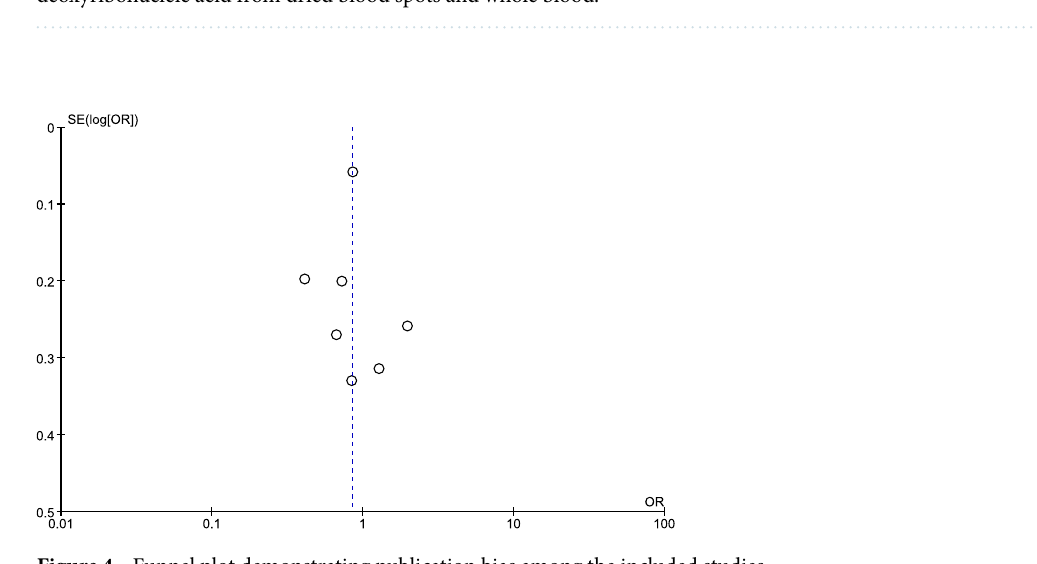
Figure 3. Subgroup analysis of Plasmodium species and the performance of polymerase chain reaction using deoxyribonucleic acid from dried blood spots and whole blood.